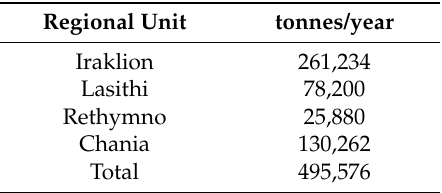
Table 4. Quantities of bi-phase oil mills